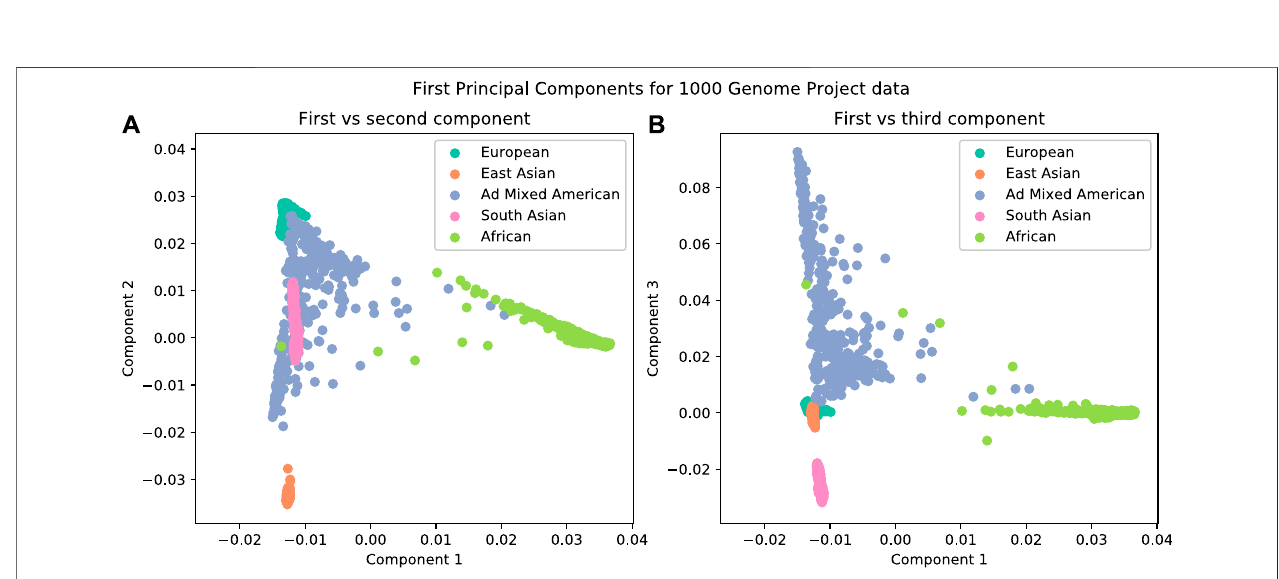
FIGURE3| The fi rstthreecomponentsfromaPrincipalComponentAnalysisondatafromthe1000GenomesProject.Aclearseparationisobservedwhenplotting the individuals by their components. (A) First vs second components. (B) First vs third components.